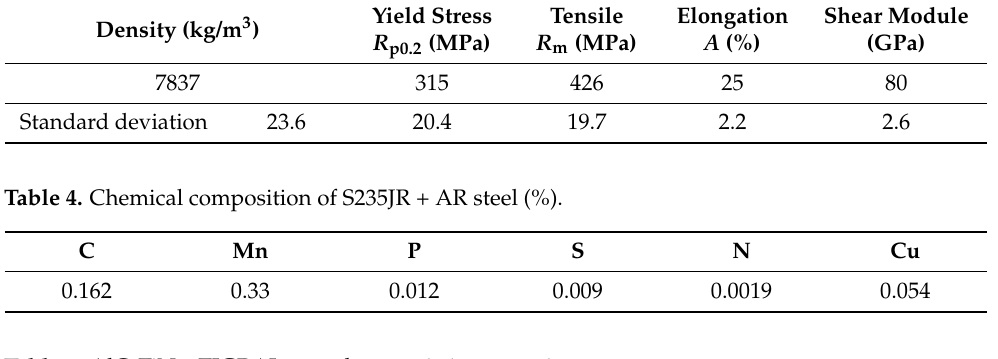
Table 5. AlCrTiN—TIGRAL coat characteristic properties. Hardness